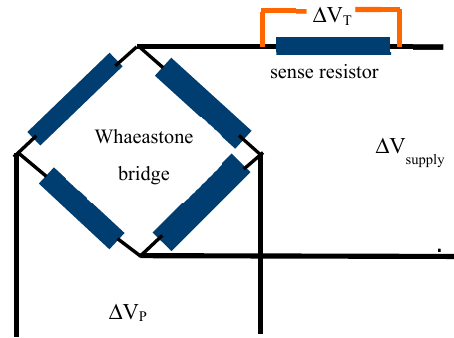
Figure 3. Electrical scheme for the pressure and temperature calibration.